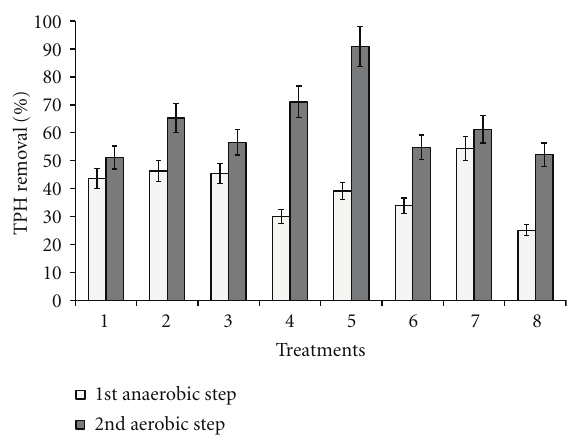
Figure 5: TPH removal in the two-step experiment in function of the operating conditions used in the anaerobic pretreatment (see Table